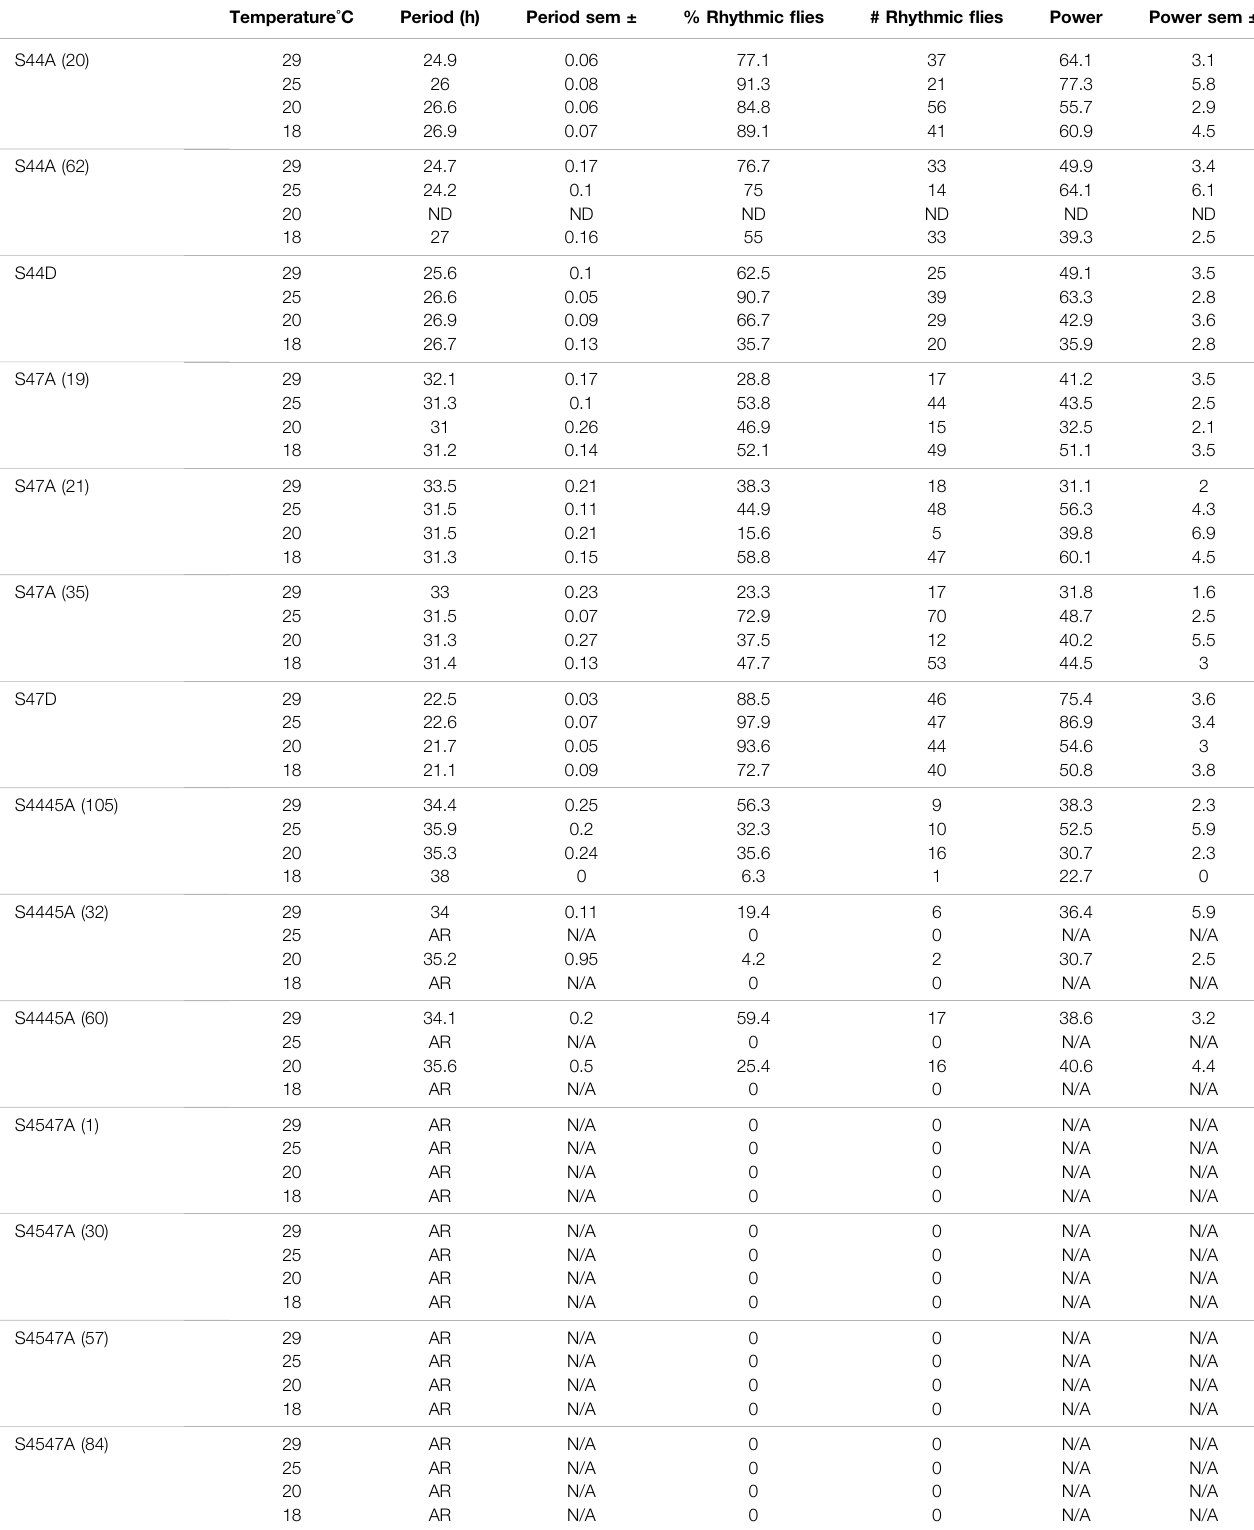
TABLE 1 | ( Continued ) Circadian behavior of control and per mutant fl ies under different temperatures. Mutations in the phosphoclusters were generated by CRISPR/Cas9- mediated genome editing. Amino acid substitutions are indicated in the left column. w 1118 is a control strain. For the per s phosphocluster, per 0 fl ies were rescued with